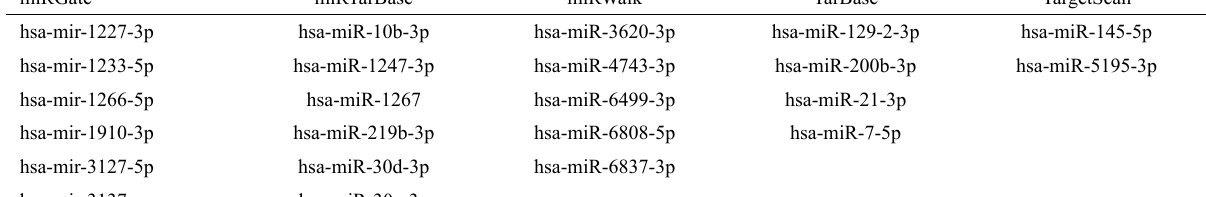
Table 3 – miRNAs associated with the BTD gene in different search methods and databases. miRGate